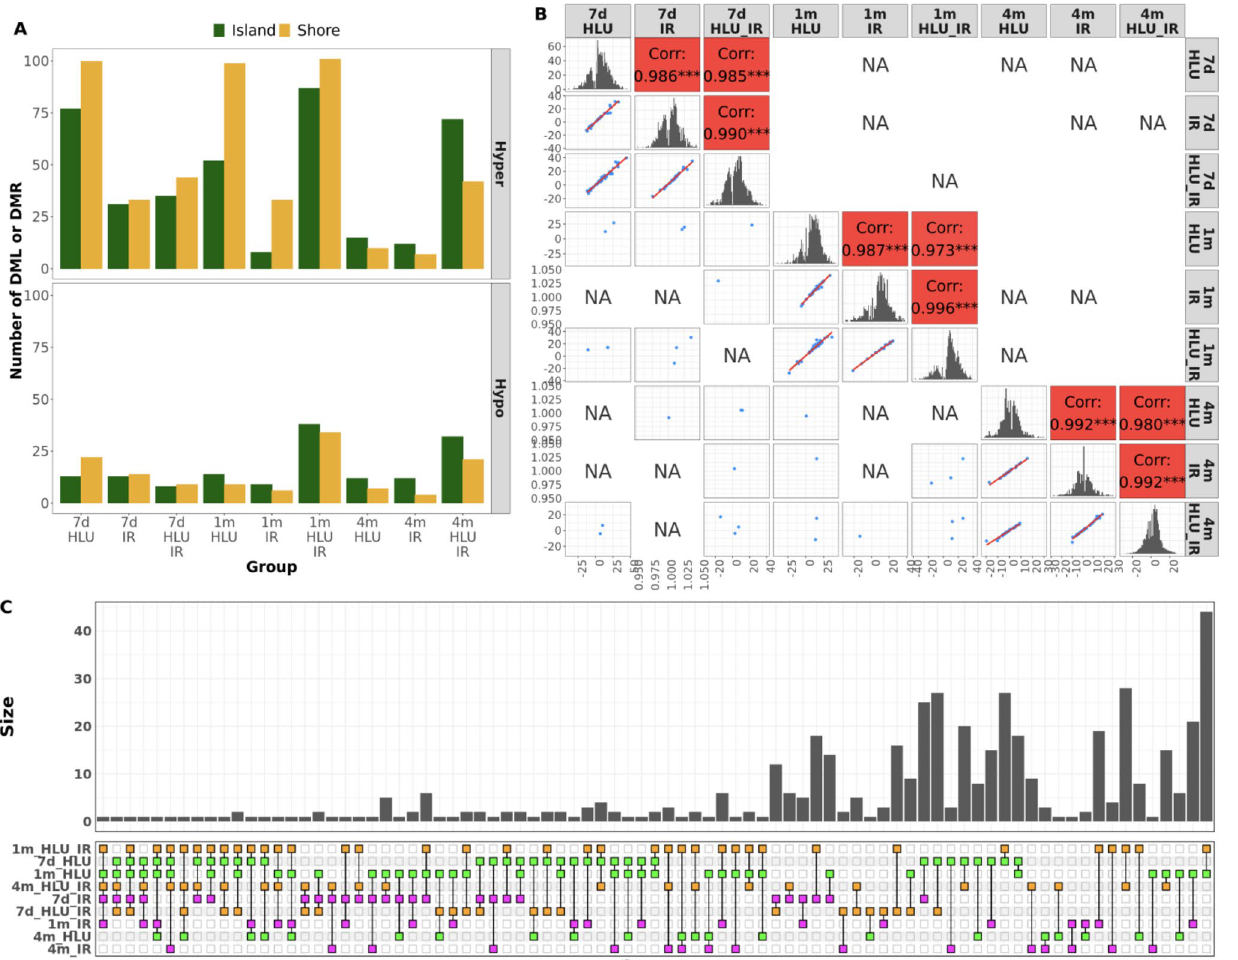
Figure 2. Differential methylation in exposure groups. ( A ) Total number of differentially methylated loci and regions within genes with hyper- or hypo-methylation in each exposure group categorized by whether they overlap with known CpG islands or shores. (B) Pairwise correlation plots for common differentially methylated sites. Differentially methylated loci (DML) with an adjusted p -value ≤ 0.05 were selected from each of the nine groups and pairwise correlation for methylation difference was plotted for any given pair. The diagonal shows distribution of methylation difference (%) between exposure and matched control group. Pearson correlation value and significance are displayed on the right of the diagonal, and scatter plots with methylation differences for common DML from any two given groups are displayed on the left. Only significant correlations (> 3 shared DML and p -value ≤ 0.05) are displayed. (C) Upset plot showing differentially methylated genes (DMG), defined as genes with their promoter or gene body containing a DML or DMR (adjusted p -value ≤ 0.05, |methylation difference|≥ 10%), shared between at least two of the nine groups. The Y-axis represents the number of genes in a given intersection set. The X-axis lists different intersection sets and is ordered by the number of intersecting groups in a given set. Dots are colored by exposure condition (magenta for IR, green for HLU, orange for combination). R package MethylKit was used for differential methylation analysis, genomation and GenomicRanges were used for annotation of DML, and ggplot2 , ggpairs and ComplexUpset were used for visualization. DML/R/G differentially methylated loci/region/gene, HLU hindlimb unloading, IR